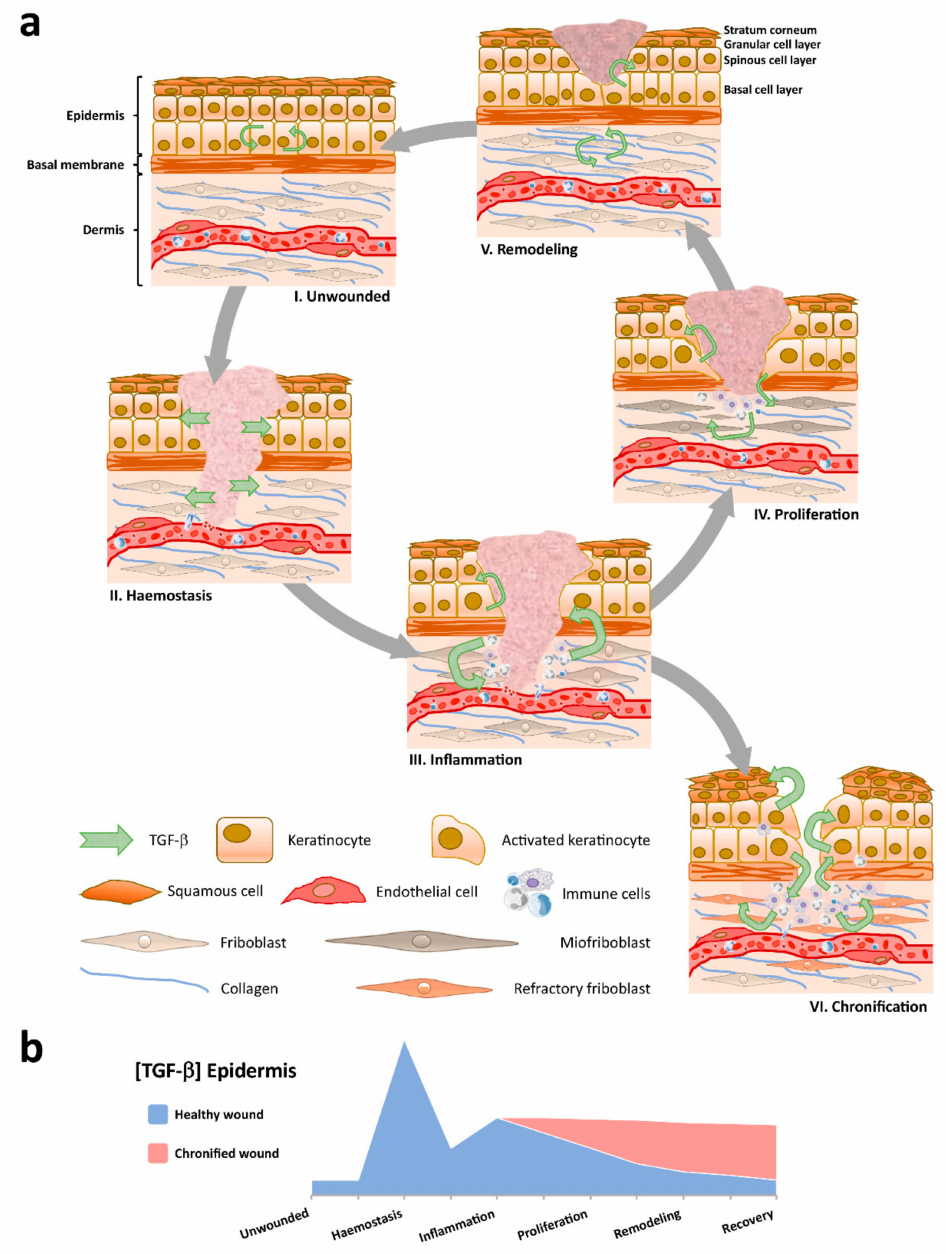
Figure 1. Spatial and temporal patterns for TGF- β evolve during wound healing. ( a ) Distinct TGF- β signatures appear through the skin tissue compartments: i) Low TGF- β levels are characteristic of the homeostatic epidermis in unwounded skin; ii) After injury, a clot is constituted and TGF- β , from degranulated platelets, di ff uses into neighboring skin tissue compartments; iii) Immune cells infiltrate and contribute to the regional cytokine milieu; iv) Molecular crosstalk between skin tissue compartments coordinates wound contraction and re-epithelization; v) Paracrine signaling drives dermal extracellular matrix (ECM) replacement and epidermal homeostasis recovery to a low TGF- β concentration environment; vi) Persistent immune infiltrates and aberrant cell behaviors establish, including dermal fibroblast becoming refractory to TGF- β signaling and the development of reactive hyperkeratosis and parakeratosis on exacerbated TGF- β expression in the epidermis. ( b ) The quantity of TGF- β varies in the epidermis through the sequential stages of wound